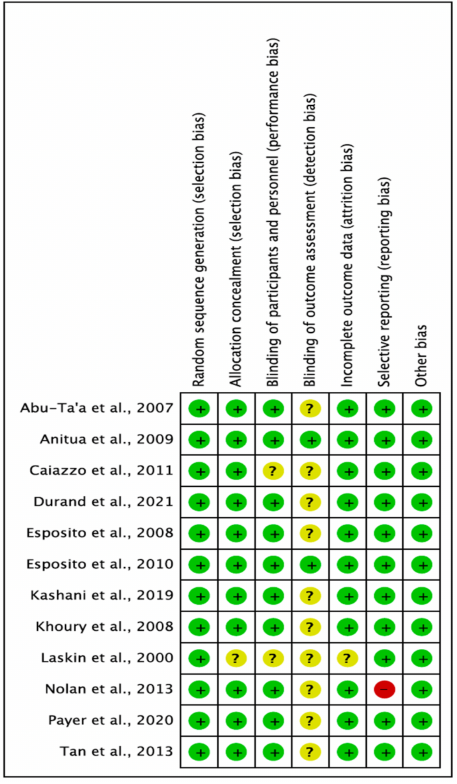
Figure 8. Each risk of bias item for each included study. Green denotes features at a low risk of bias, red denotes a feature at a high risk of bias, and yellow denotes features at an unclear risk of bias (Abu-Ta’a [32], Anitua [26], Caiazzo [25], Durand [29], Esposito [36], Esposito [31], Kashani [34], Khoury [35], Laskin [37], Nolan [33], Payer [28], Tan